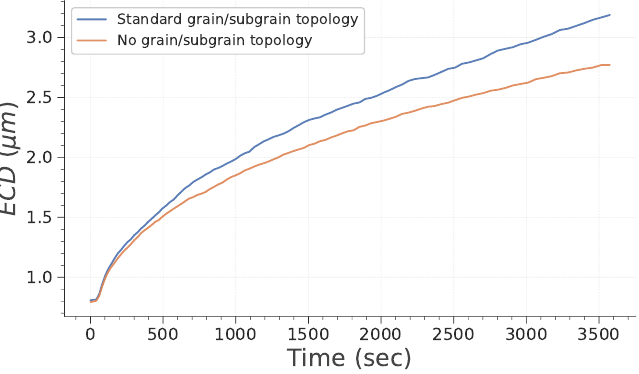
Figure 3. Evolution of subgrain average equivalent circle diameter ( ECD ) as a function of time.